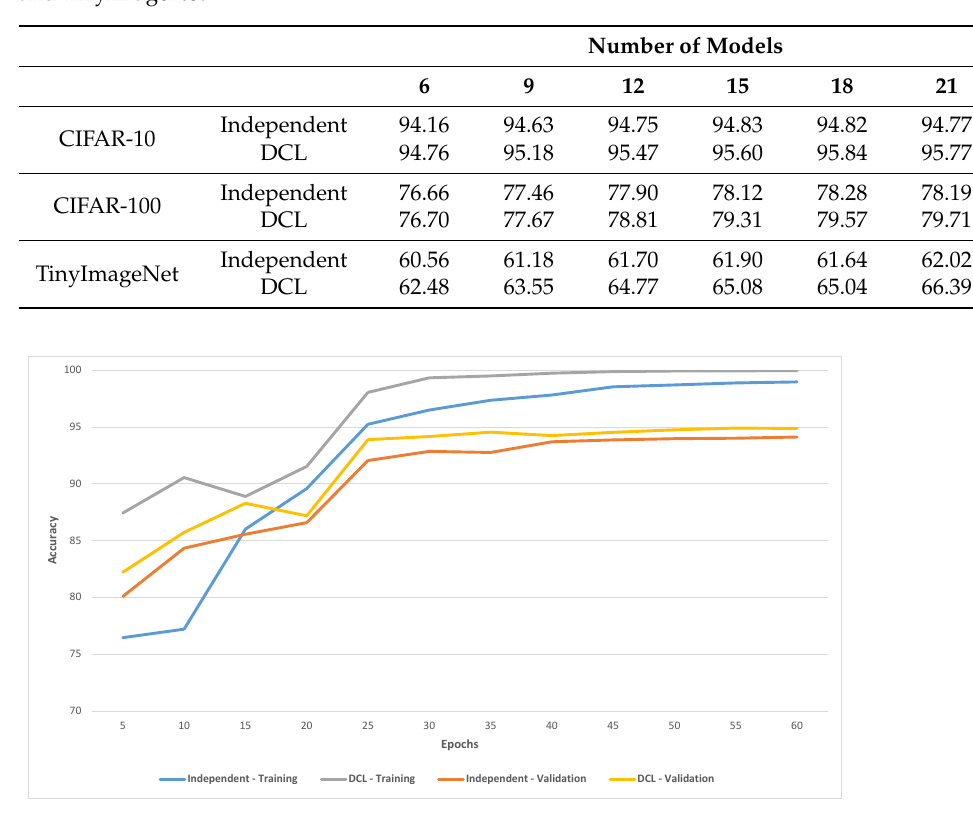
Evaluation of different sizes of DCL model ensembles on CIFAR-10, CIFAR-100, and TinyImageNet.